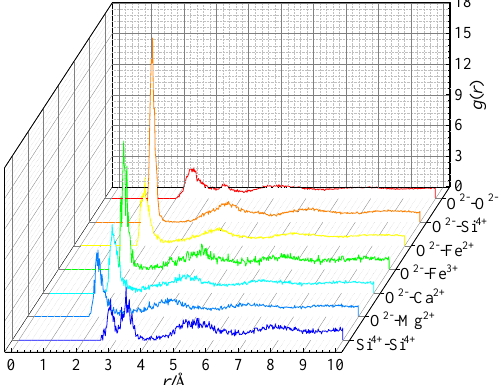
Figure 4. Radial distribution function of different ion pairs in nickel slag with 11 wt.% CaO at 1150 °C.